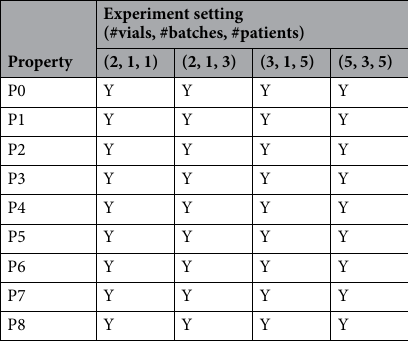
Table 4. Satisfiability of the checked properties.